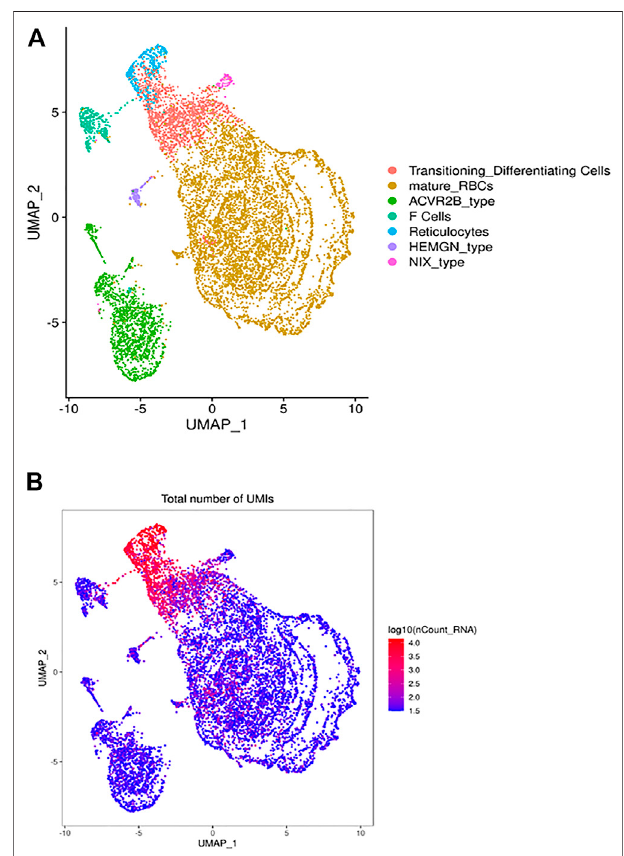
FIGURE 1 | The heterogeneous clusters ofthe circulating RBCs and the number of expressed transcripts. Leukodepleted RBC units from three different individuals were incubated at 4 ° C for one and 15 days. Aliquots of RBCs were removed from the bag, centrifuged, subjected to the single cell RNA-Seq pipeline of Chromium. (A) The UMAP presentation of the heterogeneous clusters of RBCs with the clusters identi fi ed by expressed UMIs (B) and cluster-speci fi c